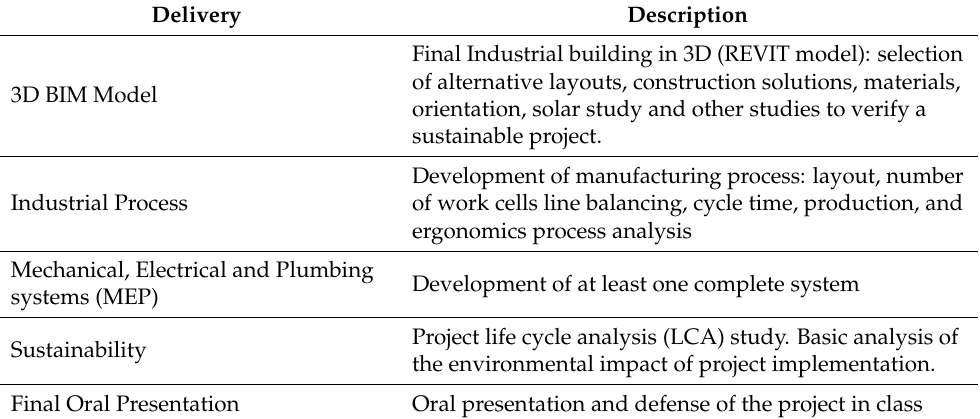
Table 3. Projects